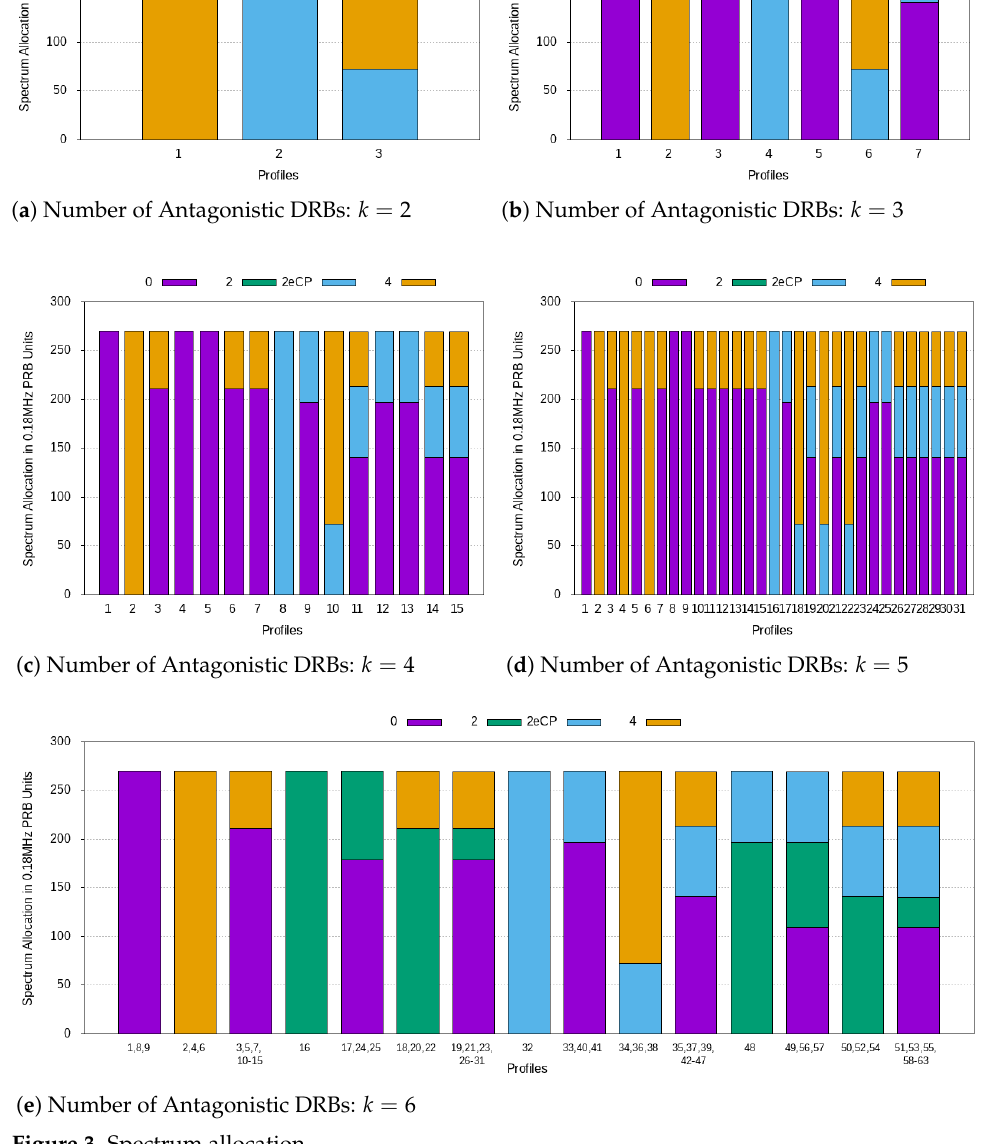
Figure 3. Spectrum